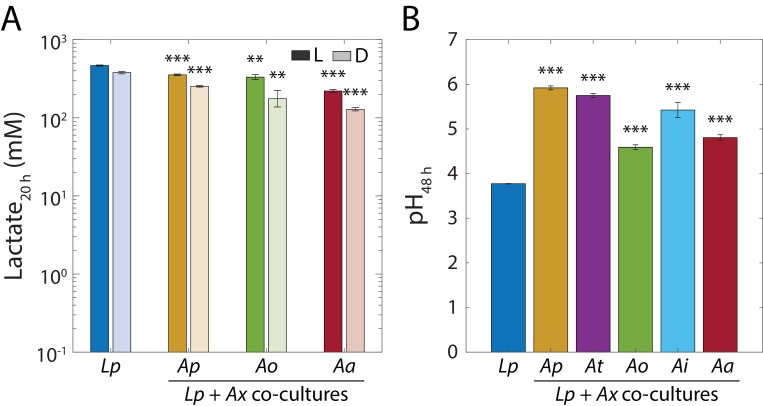
Lactate accumulates in L. plantarum (Lp) monocultures and co-cultures, and Acetobacter-driven consumption of lactate reverses the initial pH decrease.(A) Lactate is accumulated in Lp monocultures and in co-cultures with Ap, Ao and Aa before entering stationary phase. L- and D-lactate concentration was measured enzymatically from the supernatants of 20 h monocultures of Lp or co-cultures of Lp with Acetobacter species (Materials and methods). Error bars are standard deviation (S.D.) for each condition, n = 3. p-values are from a Student’s two-sided t-test of the difference from the monoculture (**: p<3×10−3, ***: p<3×10−4, equivalent to **: p<0.01/n, ***: p<1×10−3/n, where n = 3 is the number of comparisons). (B) pH in stationary phase of co-cultures of Lp is higher than monoculture. pH meter readings (Materials and methods) of saturated Lp monocultures and co-cultures with Acetobacter species. Error bars are S.D. for each condition, n = 3. p-values are from a Student’s two-sided t-test of the difference from the monoculture (***: p<2×10−4, equivalent to ***: p<1×10−3/n, where n = 5 is the number of comparisons).